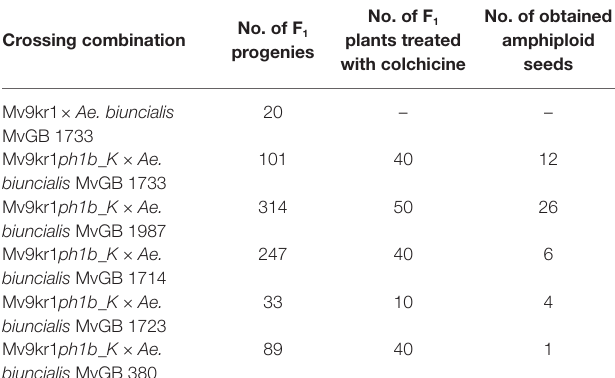
TABLE 2 | Number of F 1 progenies obtained from Mv9kr1 ph1b _K × Aegilops biuncialis crosses and the amphiploid seeds obtained by colchicine treatment of the F 1 hybrids.